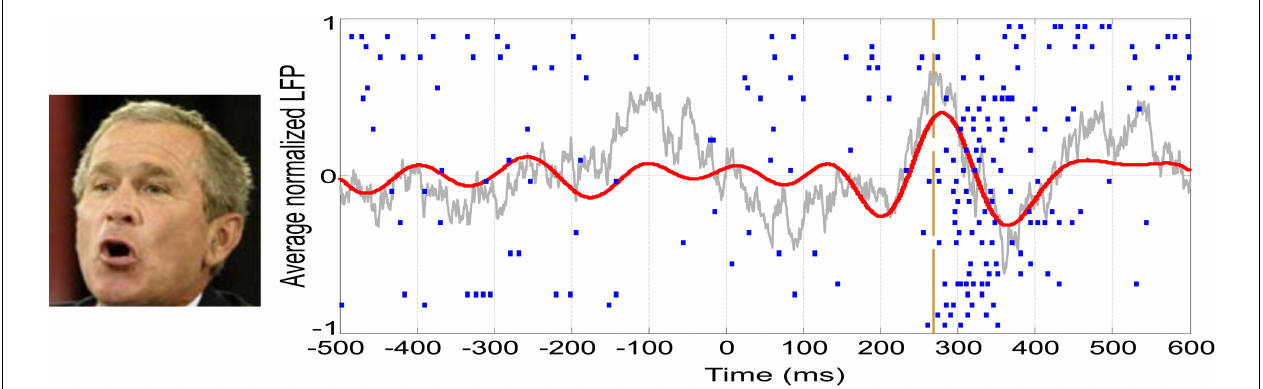
FIGURE 2 | Single-cell and LFP responses in the human medial temporal lobe. Example of a neuron in the right hippocampus showing a spiking response to a picture of George W. Bush. Each row in the raster plot is associated to one of the 30 recognized